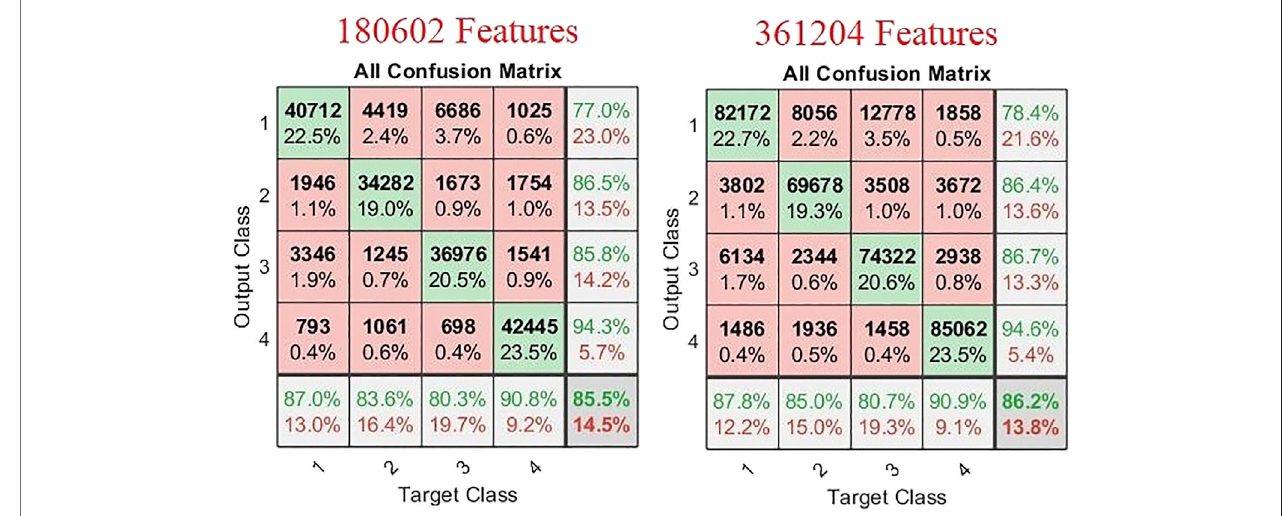
FIGURE 6 | Confusion matrices of the neural network model with different amounts of features.